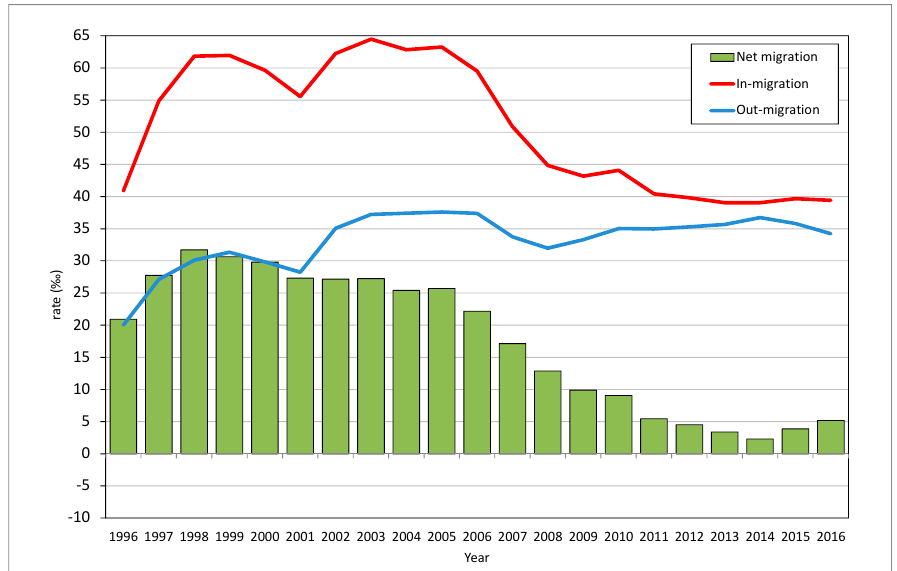
Figure 4. Component elements of the intrametropolitan migration dynamics of dispersed municipalities (1996–2016). Source: Compiled by the authors based on the Padrón continuo (Continuous Register) 1996–2017 and the Estadística de Variaciones Residenciales (Residential Change Statistics) 1996–2016, microdata file, INE.